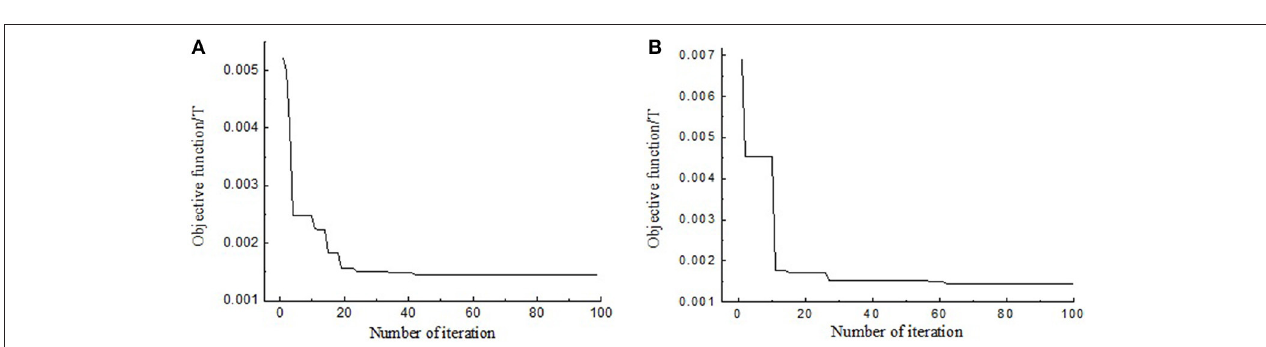
Iteration Value of times objective function using LSM (Tesla)